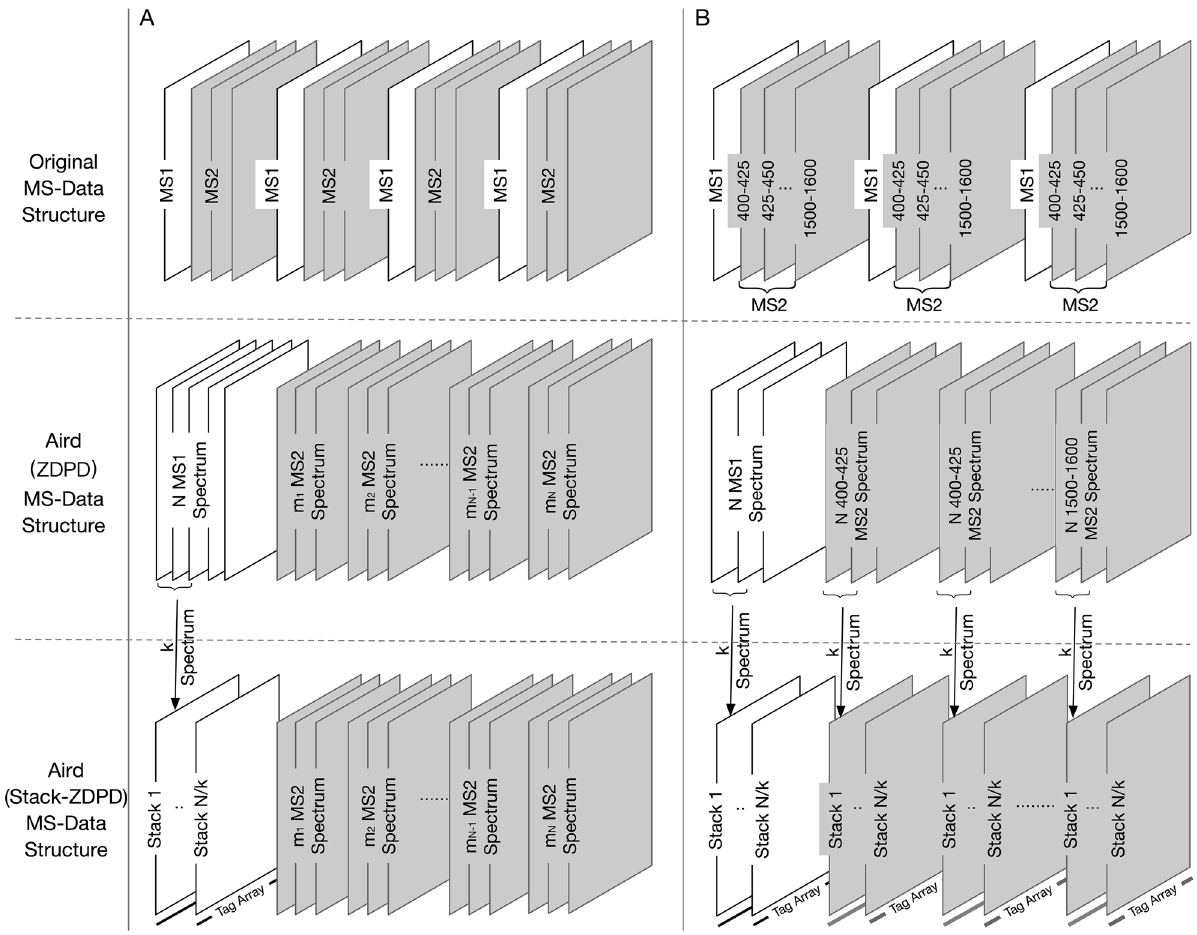
Figure 7. ( A ) MS-Data structures in data acquisition mode of DDA. In DDA mode, each MS1 spectra is originally followed by several relevant MS2 spectra. In data organization of Aird (ZDPD), MS1 spectra are gathered as MS1 block to accelerate the extracted ion chromatogram (XIC) calculation. According to Stack- ZDPD, each k spectra are combined before compression, so the output data is composed of several stacks, the merged spectrums. Each stack is stored along with a Zlib-compressed tag array for decoding. It should be noted that the number of spectra mi in the MS2 block is often not very large, thus MS2 data keeps the structure in Aird (ZDPD). ( B ) MS-Data structures in SWATH/DIA mode. Different from DDA mode, each MS2 spectra in DIA is set to a certain m/z SWATH window and MS2 data in the same window is generally extracted for analysis. Therefore, MS2 data is stored as MS2 blocks according to its m/z SWATH window and spectrum number of each MS2 block is theoretically same as MS1 block. Further, data in each block is stored as stacks to achieve better compression